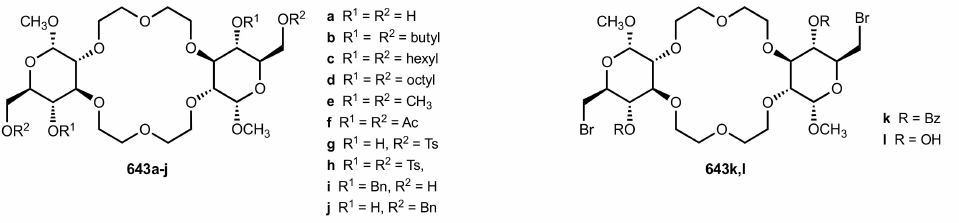
Figure 43. The synthesis of a series of C 2 -symmetric crown